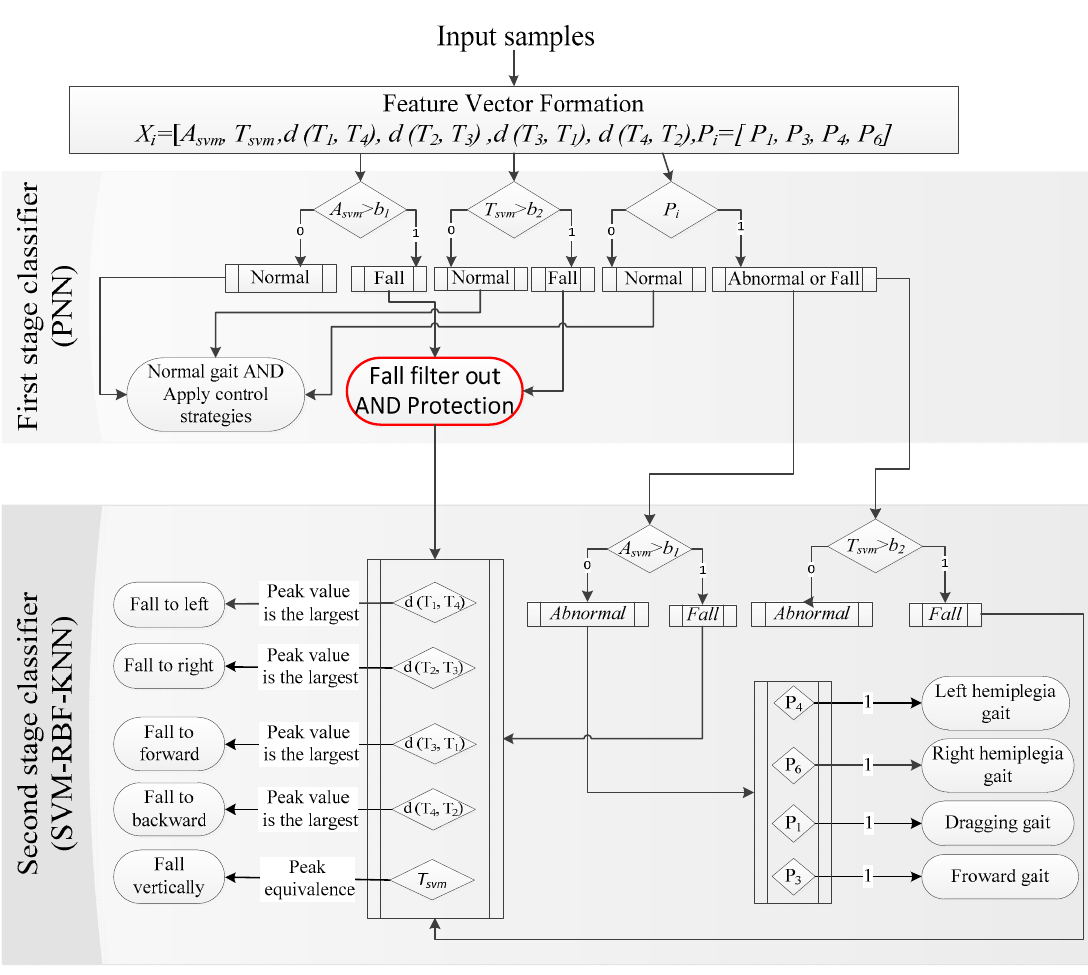
Figure 5. The two-stage activity recognition classifier.